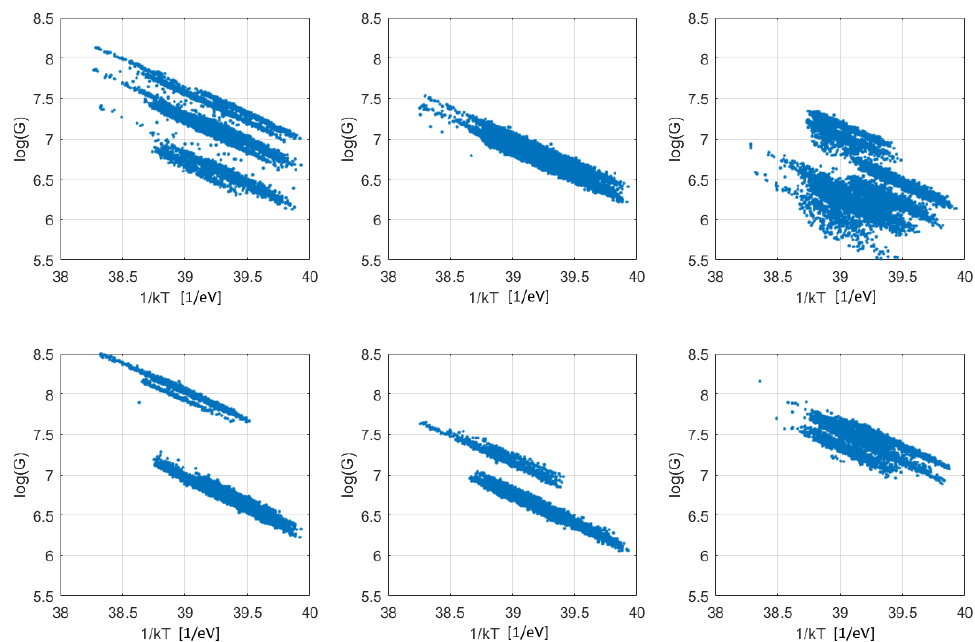
Figure 4. Examples of Arrhenius plots for metastable dark current. The plots show measurements of six random defective pixels in BAb CCD in 2014 ( VelPup field, setup no. 6).